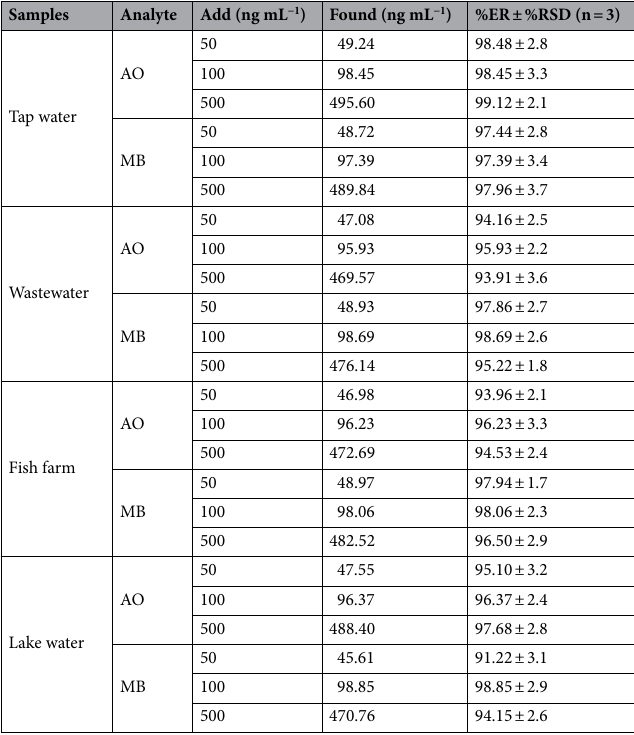
Table 6. Determination of AO and MB in the environmental water